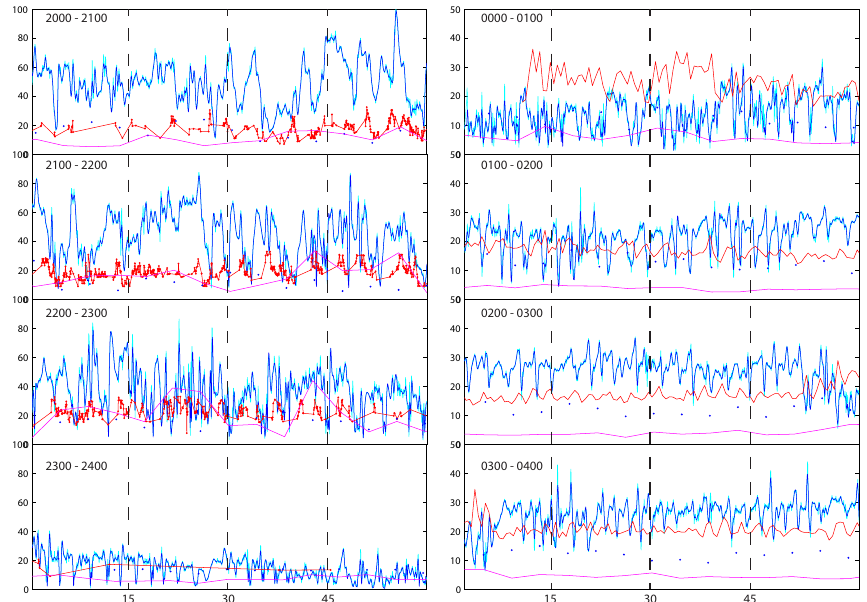
Figure 7. Eight 1h intervals of the magnetic field strength B m , left column before midnight of 6 until 7 June and right column after midnight. The cyan line is B m and the blue is the low-pass filtered field. The magenta line is the IES ion density and the blue dotted line is the IES electron density, the red line and dots are the MIP electron density in the left panels and the LAP P1 current in the right panels. Because of the various different quantities plotted in the panels there are no labels on the y